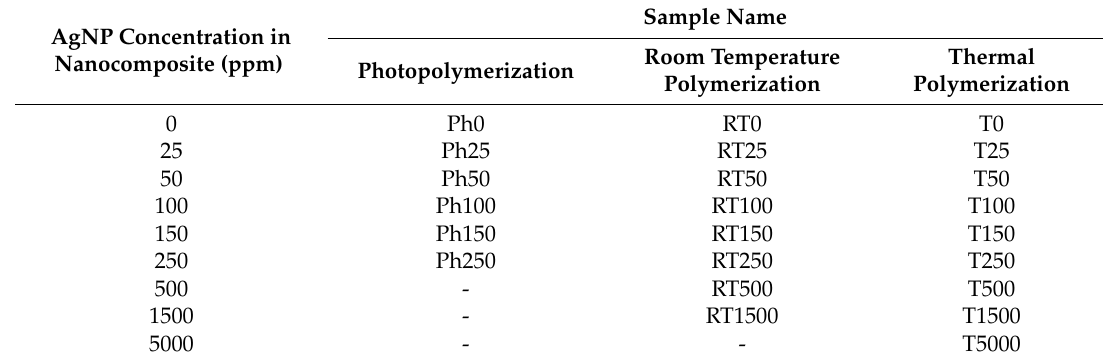
Table 2. The Bis-GMA/TEGDMA/AgNP nanocomposite samples studied and their names: Ph (photopolymerization), RT (room temperature polymerization), T (thermal polymerization).